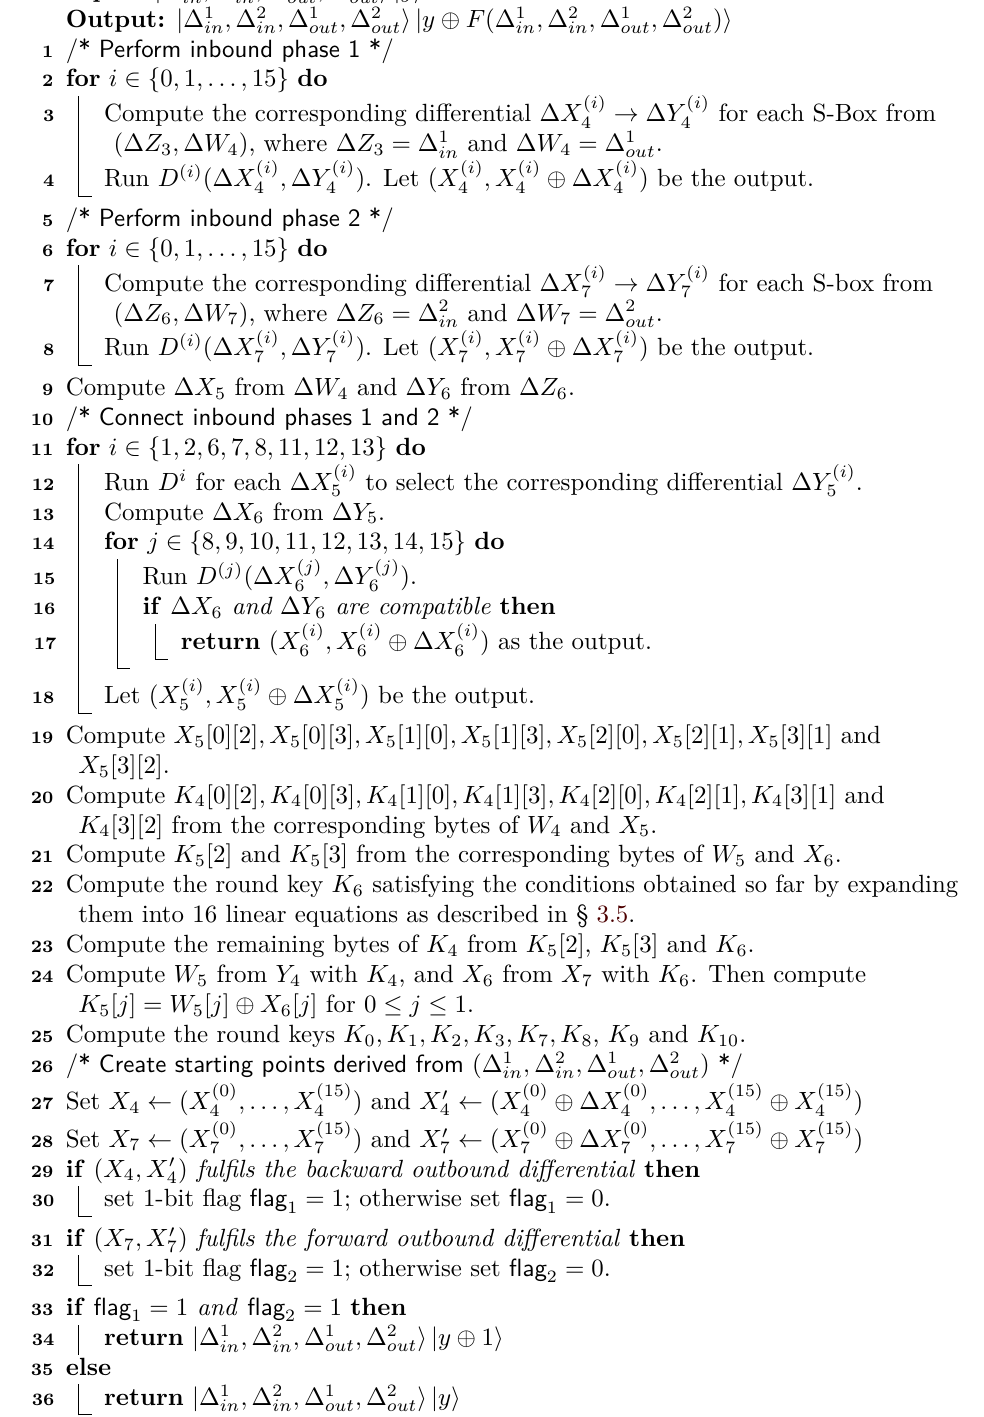
Algorithm 2: Implementation of U